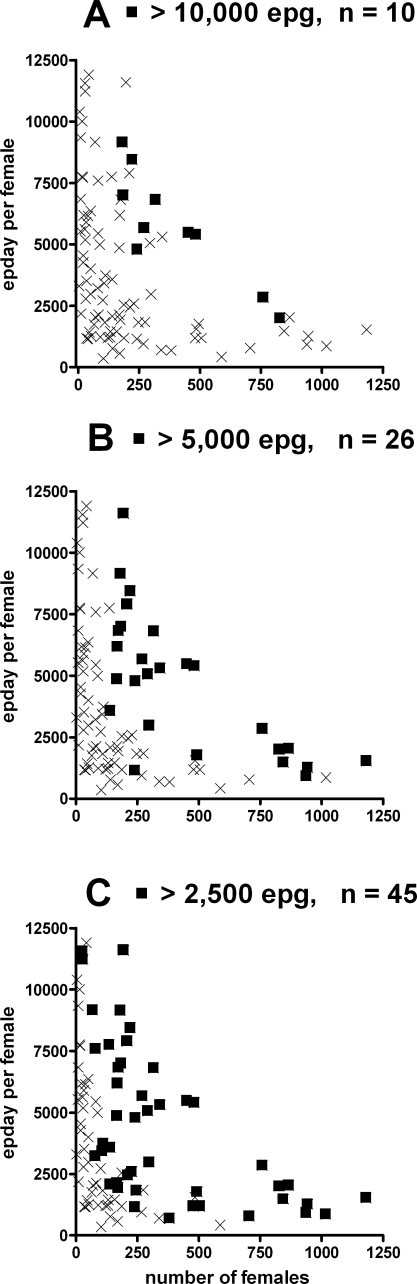
An examination of epg prior to drug treatment as a predictor of the level of density dependent fecundity constraint imposed on worm populations using the data set of Hill [18].Parts A, B, C highlight cases with epg >10,000, >5,000, or >2,500, respectively, as ▪; all other cases are shown as x.